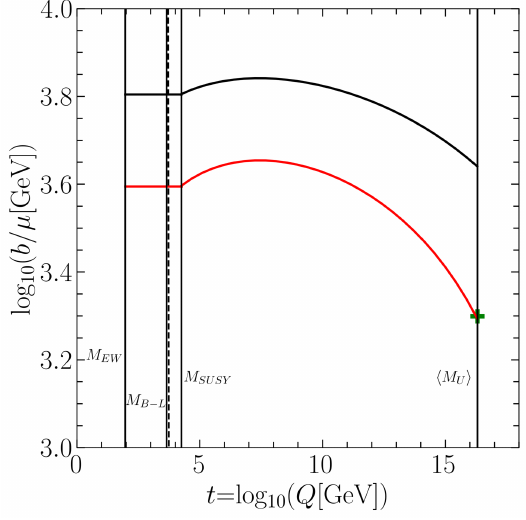
Figure 4 : We show how the ratio b/µ runs between the EW scale and the unification scale for two different points in our simulation. The red line corresponds to the acceptable “black” point circled in red in figure 3 and with initial data shown in (6.16). This point corresponds to an “upside-down” hierarchy with M = 4 , 257 GeV, M = 18 , 101 GeV BL SUSY (these scales are indicated with vertical solid lines). The ratio b/µ runs from 3 , 936 GeV at the EW scale, to 2 , 008 GeV near the unification scale. This matches the high energy value predicted in (6.22), and is marked with a green cross. The black line corresponds to the unacceptable “black” point circled with black in figure 3 and which has initial data shown in (6.23). This point corresponds to an “upside-down” hierarchy with M = 6 , 099 GeV, BL = 18 , 845 GeV (these scales are indicated with vertical dashed lines, though they are M SUSY very close to the solid lines in the “acceptable” case). The ratio b/µ runs from 6 , 433 GeV